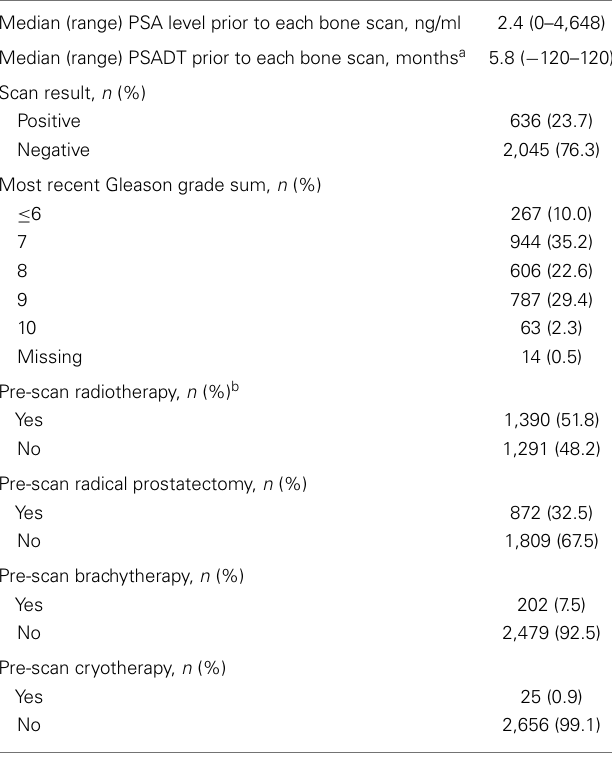
Table 1 | Patient and disease characteristics at each bone scan ( n = 2,681) .